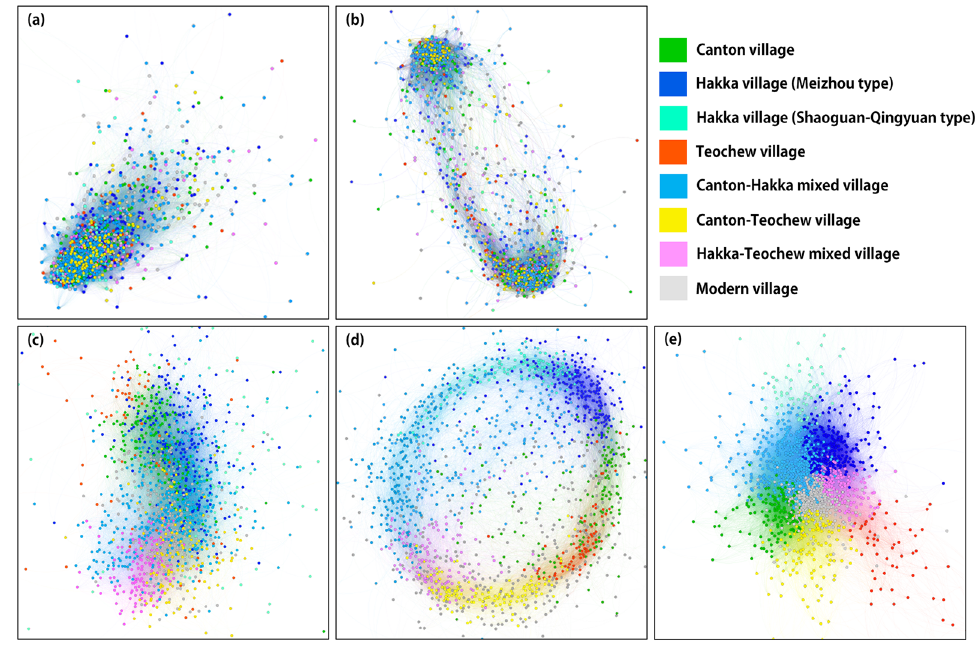
Fig. 10 The village networks were computed using different methods. The node colour represents the cluster group derived from panel ( e ). Panel a shows the village network computed by the original 256-channel feature maps. Panel b shows the result based on the 11 principal components from PCA analysis of the 256-channel feature maps. Panel ( c ) shows the result using the 256-channel feature maps at the building scale. Pane d is the 11 principal components from PCA analysis of the 256-channel feature maps at the building scale. Panel e is the result using the XDR framework. HUMANITIES AND SOCIAL SCIENCES COMMUNICATIONS| (2023) 10:35